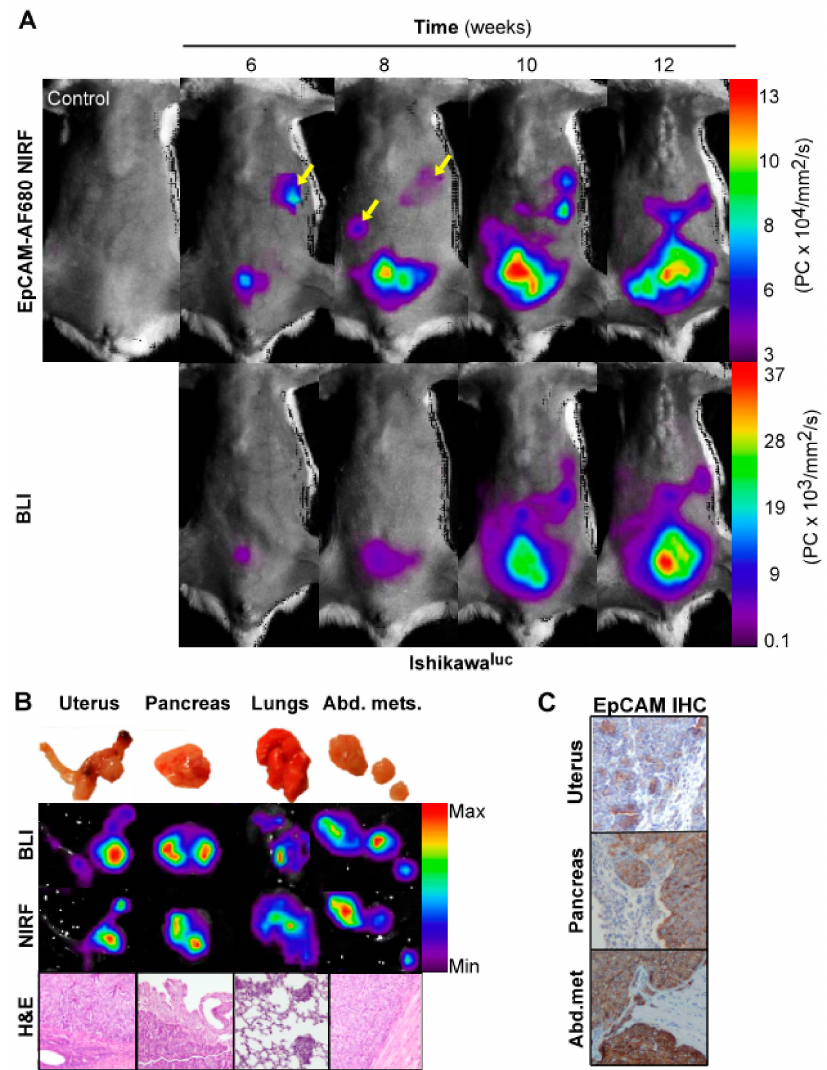
Figure 3. Optical imaging of tumor growth in an orthotopic Ishikawa luc + xenograft model. In vivo BLI and EpCAM-AF680 NIRF imaging of primary tumor growth in mice orthotopically implanted with Ishikawa luc + cells. Metastatic lesions (arrows) were detected at an earlier time point in EpCAM-AF680 NIRF images. A tumor free mouse was used as control (upper left) ( A ). Macroscopic images of uterus, pancreas, lungs and abdominal metastases ( B , upper panel) and corresponding ex vivo BLI and EpCAM-AF680 NIRF images ( B , middle panels). Tumor cells are demonstrated in H&E stained sections (20x magnification) ( B , lower panel). Positive EpCAM expression in primary tumor and metastases is demonstrated by IHC ( C ). Abbreviations: Bioluminescent imaging (BLI), Epithelial cell adhesion molecule (EpCAM), Hematoxylin and eosin (H&E), Immunohistochemistry (IHC), and Near-infrared fluorescence